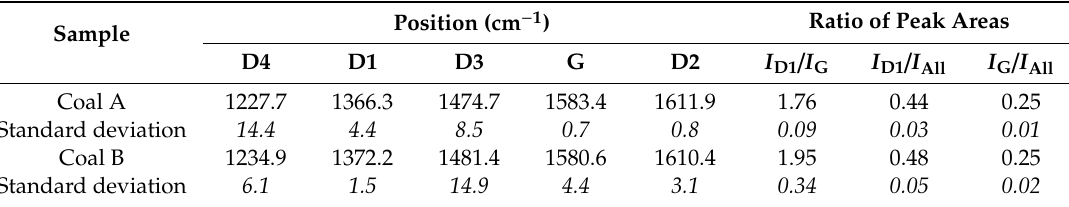
Figure 3. Raman spectra of coal samples: ( a ) Coal A and ( b ) coal B. Table 4. Peak parameters of Raman spectra of